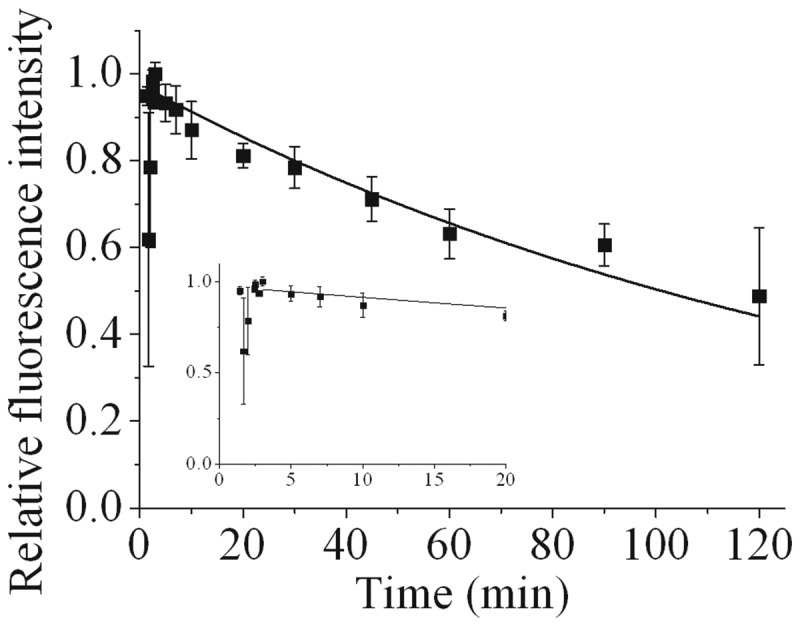
Dependence of the recruitment and loss of fluorescence intensity of DNA-PKcs-YFP on time following NIR microbeam irradiation with 730 nm photons (at a power of 10 mW through a ×60 objective) in cycling cells. For real-time analysis, each point represents the relative fluorescence intensity normalized to the intensity at ‘zero time’ following irradiation and maintaining the cells at 37°C. The kinetic analysis to obtain the best fit to the experimental data are shown as solid lines and described in the Materials and Methods section. The insets represent the data expanded to show the first 20 min in more detail.